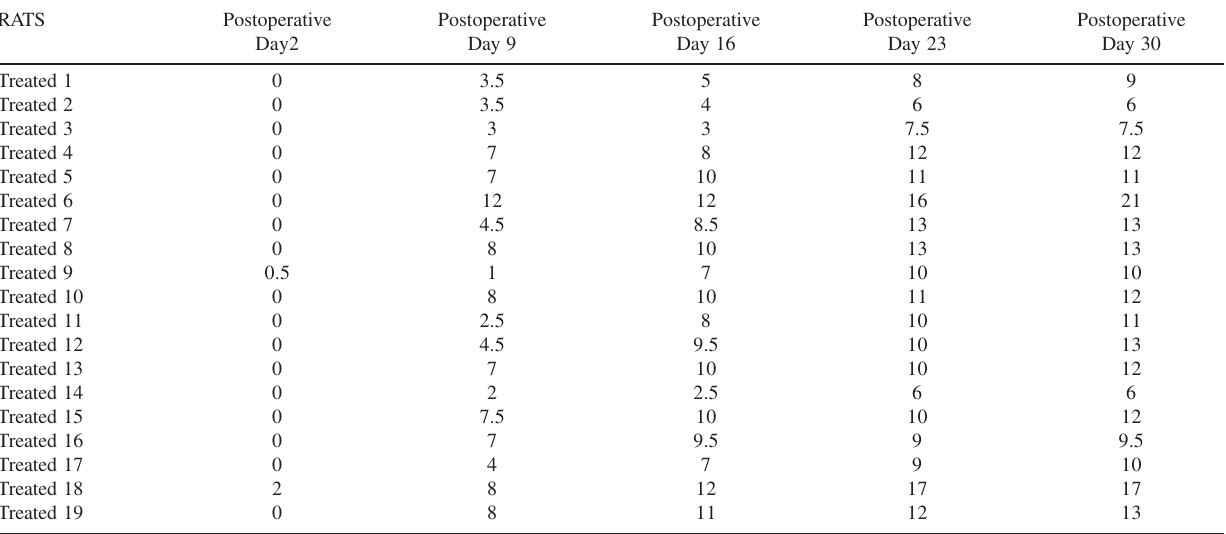
Table 4 - Functional evaluation, NT-3 group RATS